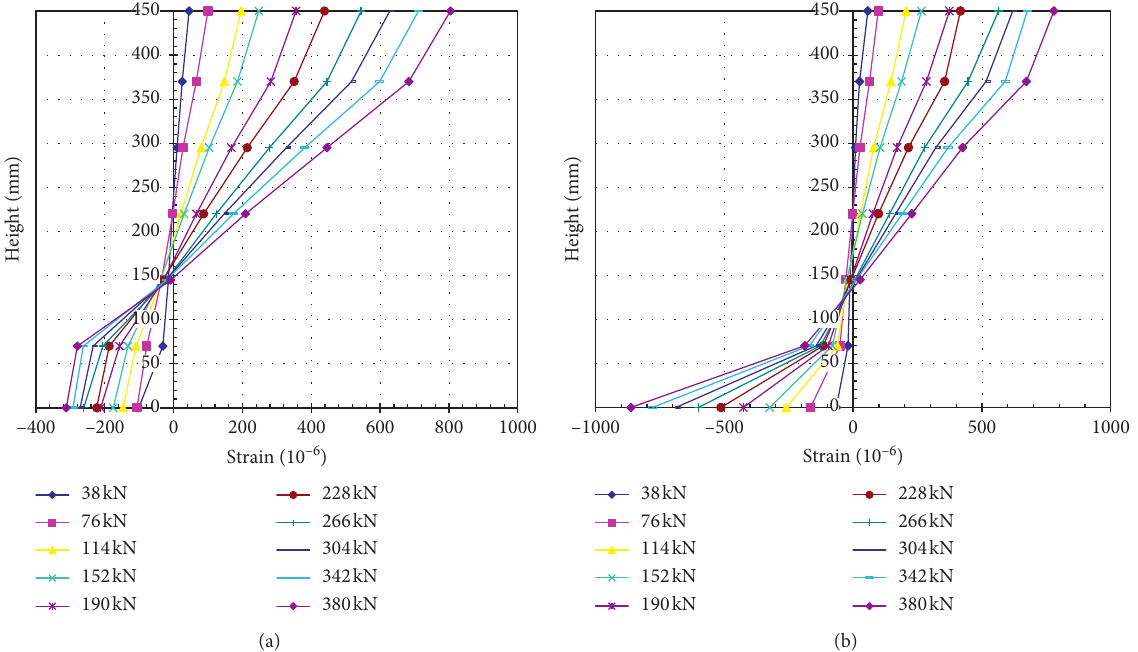
Figure 29: Curve of strain of PLG-1 steel beam with height. (a) Center line section (after 1 million cycles). (b) 0.5 times the beam height section (after 1 million